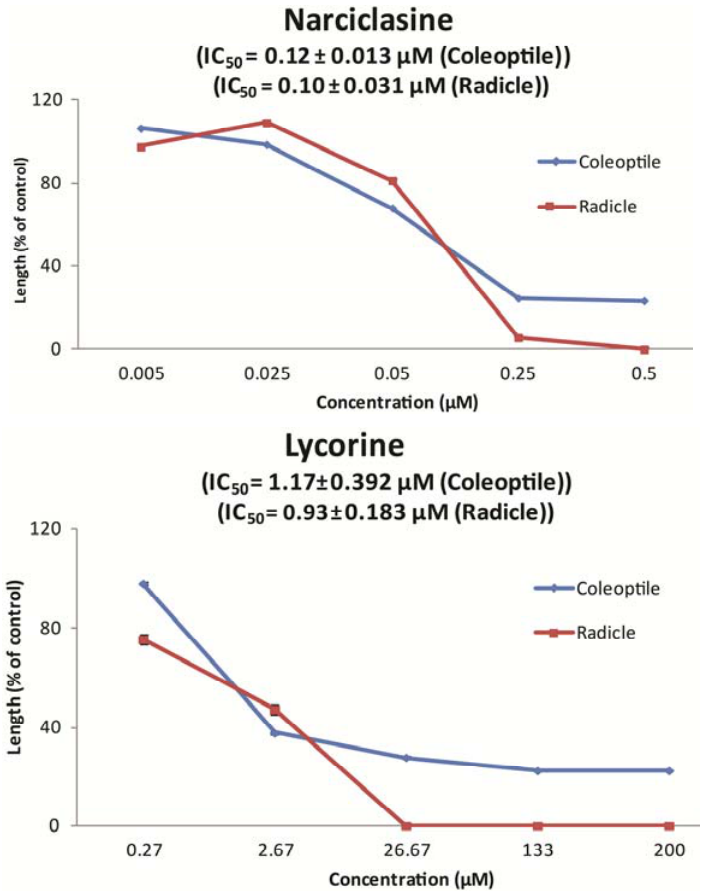
Figure 2. Dose-response curves of growth inhibition of Senecio vulgaris seedlings treated with narciclasine and lycorine. Data present the mean and standard deviation of three replicates. Where not visible, bars fall within